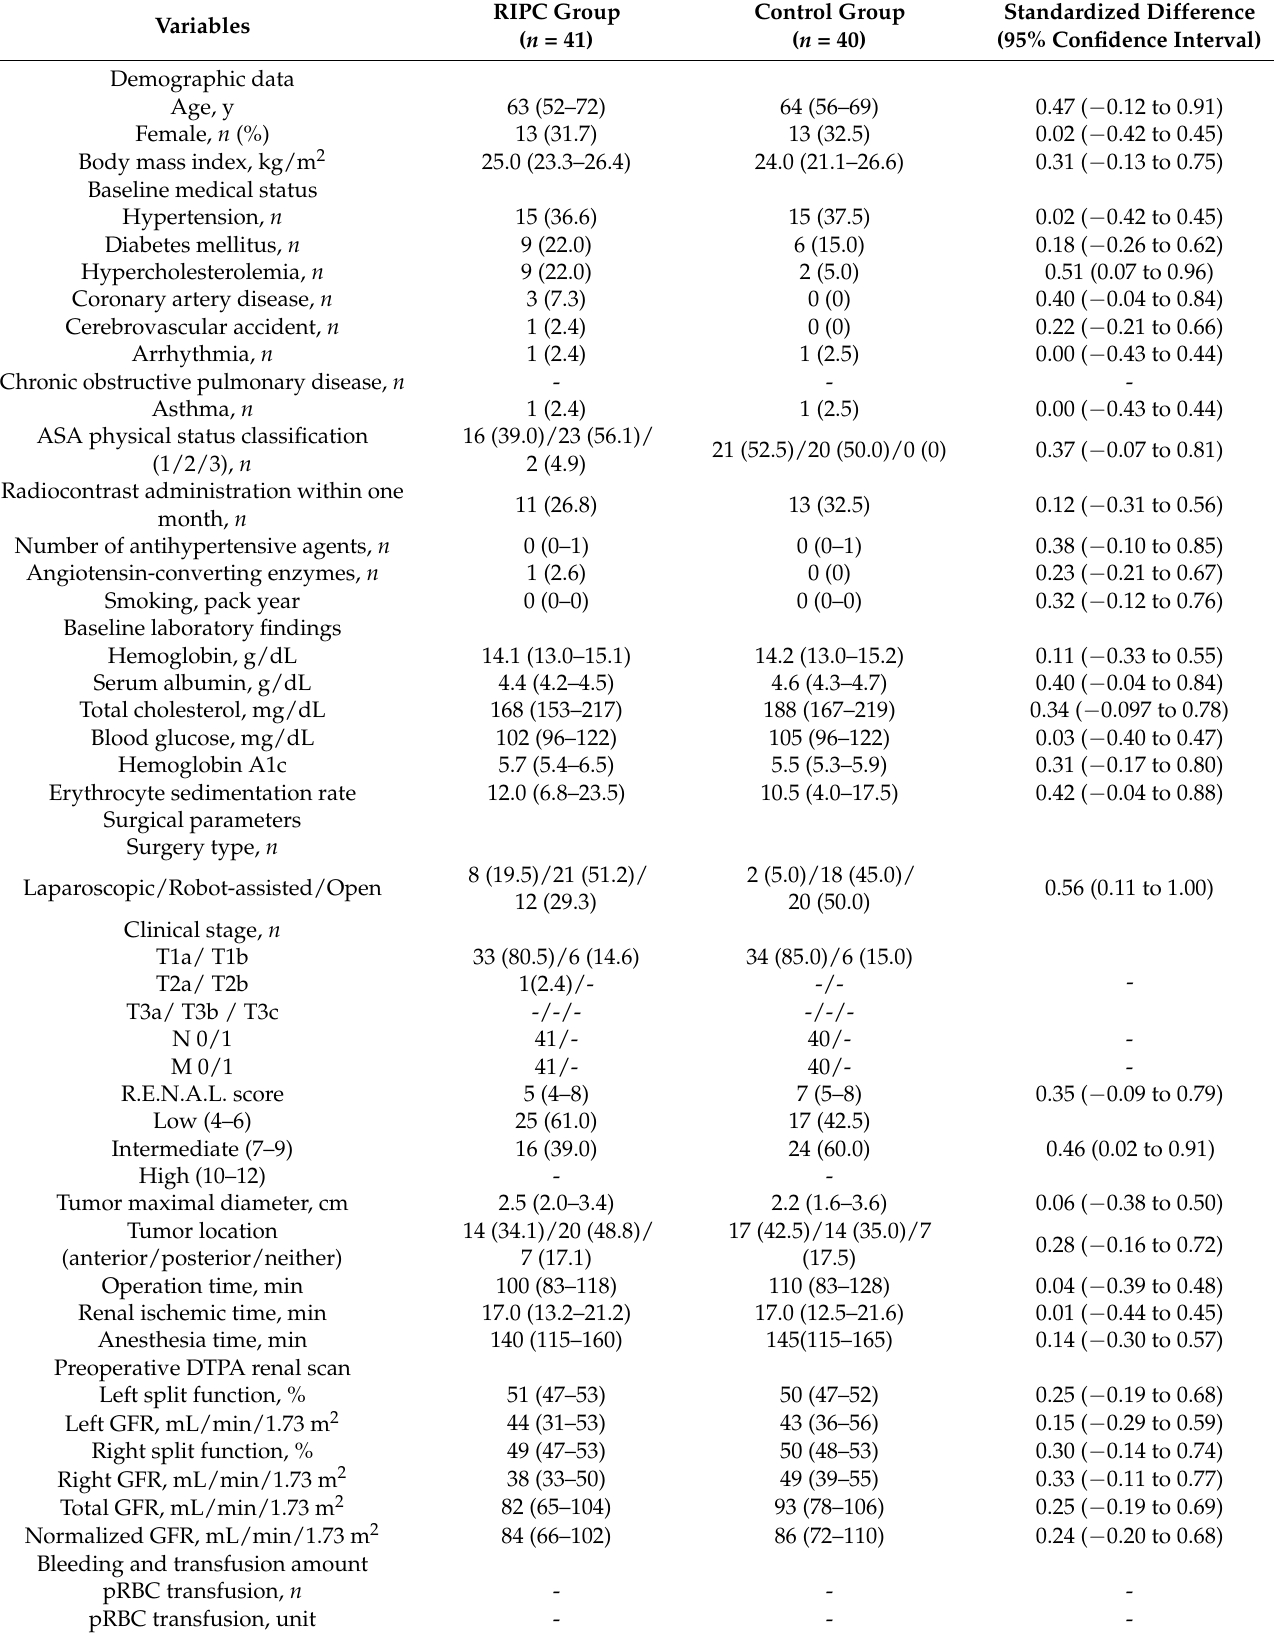
Table 1. Patient characteristics and perioperative